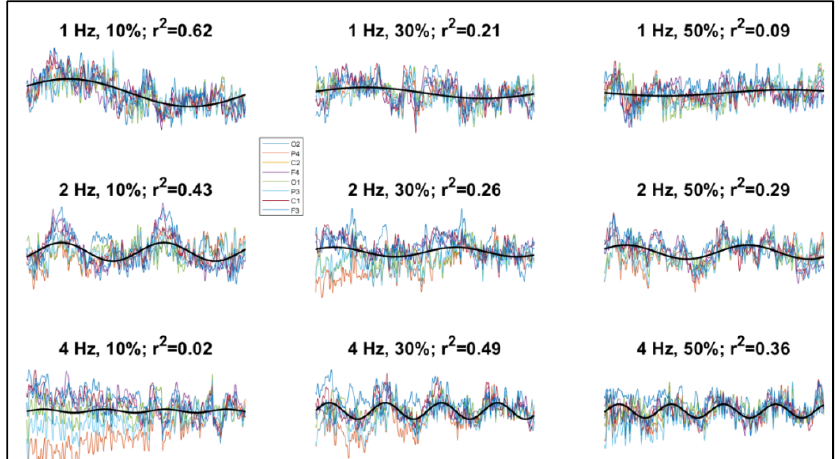
Figure 3. Examples of electroencephalographic (EEG) recordings from one participant showing the traces from all channels (shown in different colors, see legend), averaged across a 1 ‐ s time window and superimposed. The sinusoidal best ‐ fitting curves are also shown (black lines; for graphical simplicity, here only a single curve averaged across channels is shown). Also reported are the values of stimulus modulation frequency, stimulus modulation strength, and adjusted R 2 of the fitted functions.